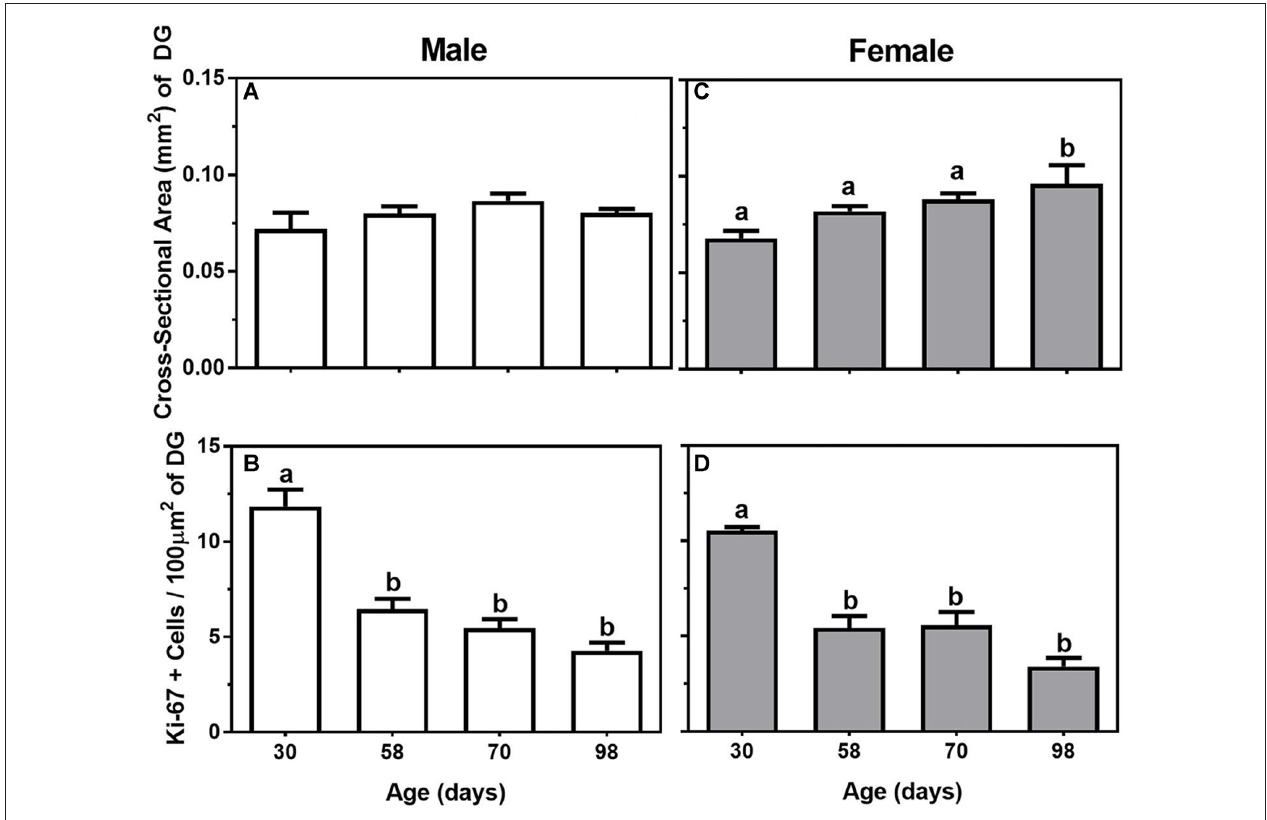
FIGURE 2 | Mean ( ± SEM) cross-sectional area (mm 2 ) of the dentate gyrus (DG) and number of Ki-67-positive cells per 100 µ m 2 of DG in 30-, 58-, 70-, and 98-day-old male ( A,B ; left panels) and female ( C,D ; right panels) mice. Bars that share a letter are not significantly different from one another.